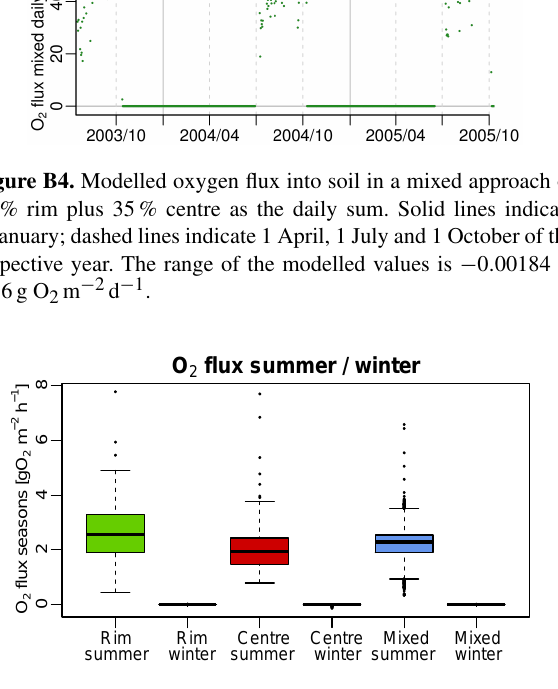
Figure B5. Modelled oxygen flux into the soil at the rim, the centre and a mixed approach of 65% rim plus 35% centre, split into sum- mer and winter. Summer means less than 5cm of snow are on the ground; winter is the remainder. Because of the wide spread of val- ues, to as high as 16.3g O 2 m − 2 h − 1 , a portion of 0.0118% values was cut to provide a reasonable picture. The minimum of the values is − 0 . 136g O 2 m − 2 h − 1